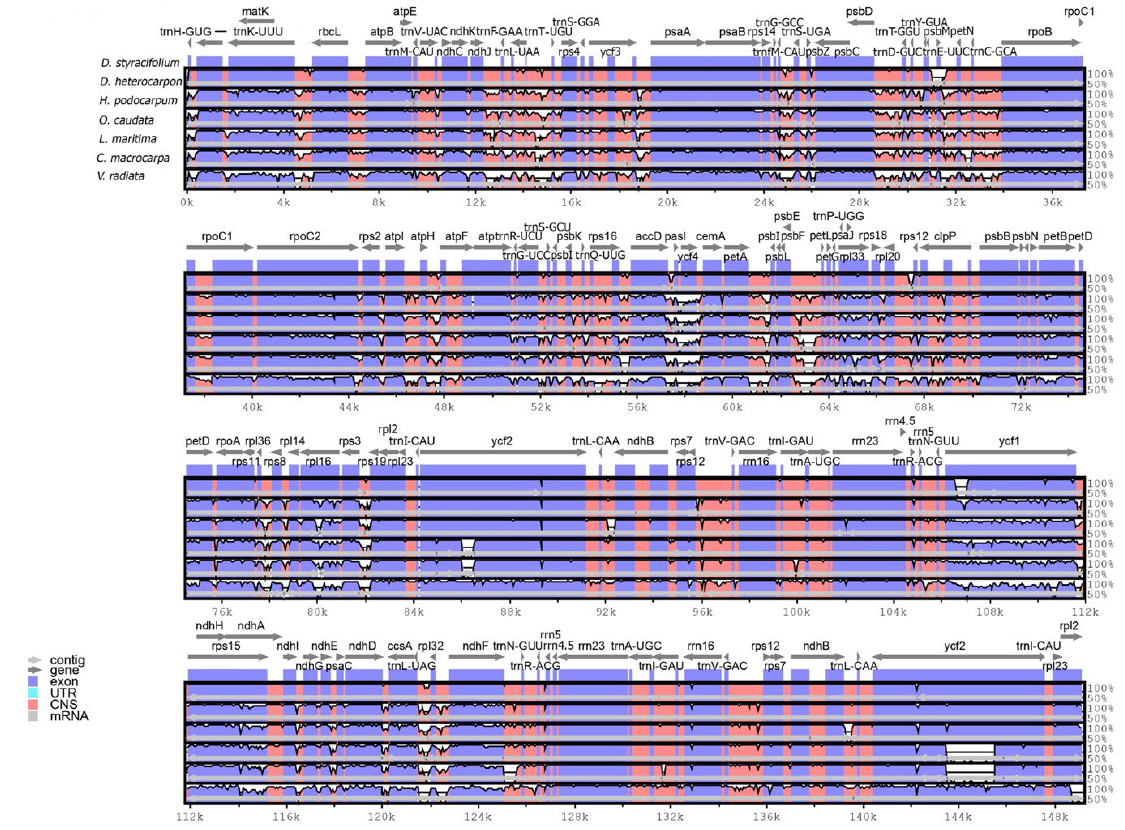
Figure 2. Sequence identify plot for seven Phaseoloid species using mVISTA with Desmodium styracifolium as a reference. Gray arrows represent gene orientation and position. The Y-axis indicates the percentage identity between 50 and 100%. Red and blue bars indicate non-coding sequences (CNSs) and exons, respectively.